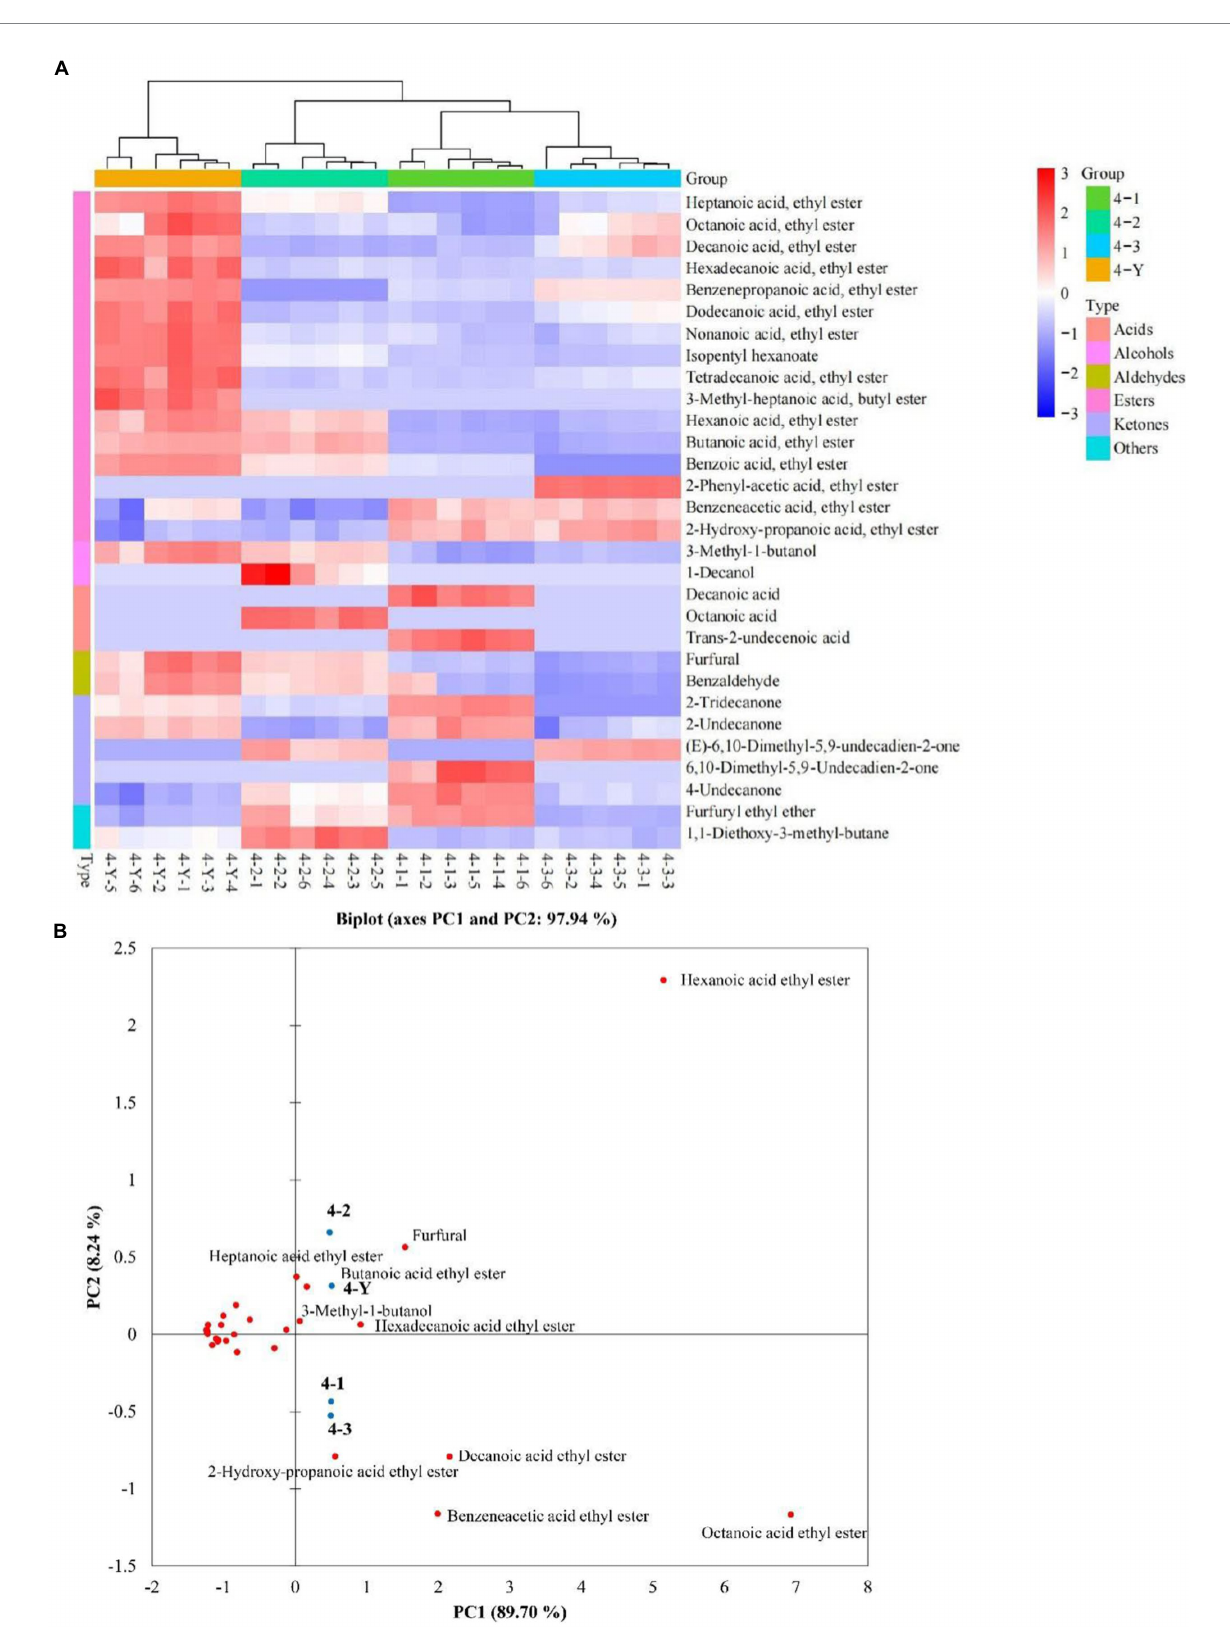
FIGURE 7 Heatmap (A) and principal component analysis (PCA) biplot (B) of differential compounds in different quality grades of base liquor of 4th round of